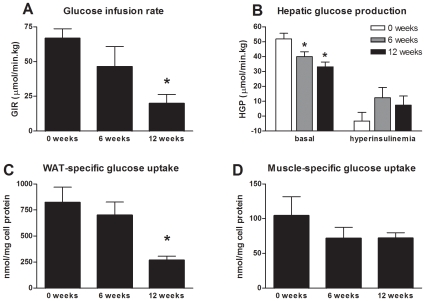
Glucose tolerance test and hyperinsulinemic, euglycemic clamp analysis.In a parallel, independent animal experiment, HFD-fed mice were subjected to hyperinsulinemic, euglycemic clamp analysis. (A) shows the glucose infusion rate (GIR) under hyperinsulinemic conditions. Radioactive tracers allowed determining hepatic glucose production rate (HGP) (B) as well as the tissue-specific uptake of glucose into WAT (C) and skeletal muscle (D). ‘Basal’ indicates prior to hyperinsulinemic clamp conditions and ‘hyper’ indicates hyperinsulinemic clamp conditions. Values are means ± SEM. *P<0.05 vs. t = 0.